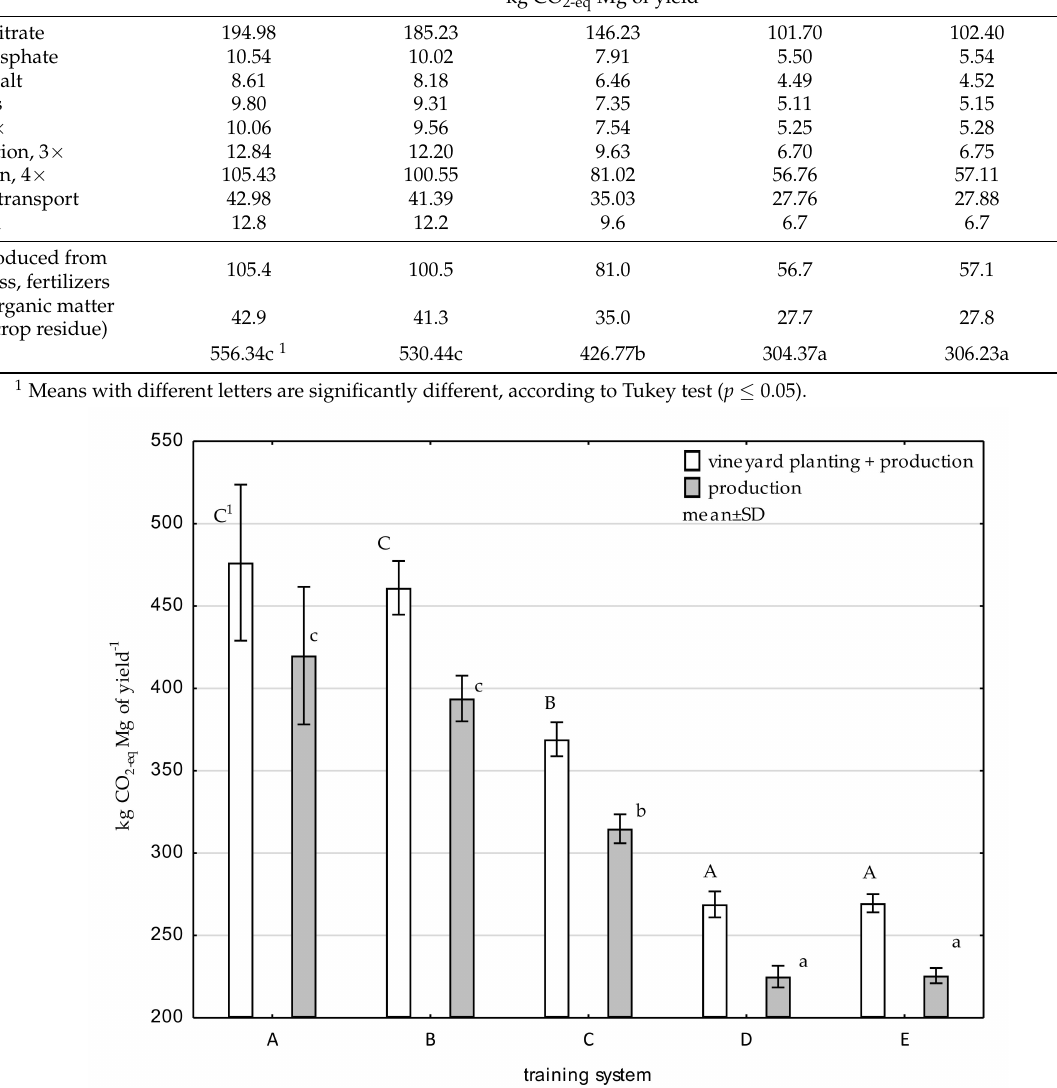
Figure 3. Average GHG emissions per 1 Mg of fresh fruit yield per training system (A, B, C, D, E). 1 Means with different letters are significantly different, according to Tukey test ( p ≤